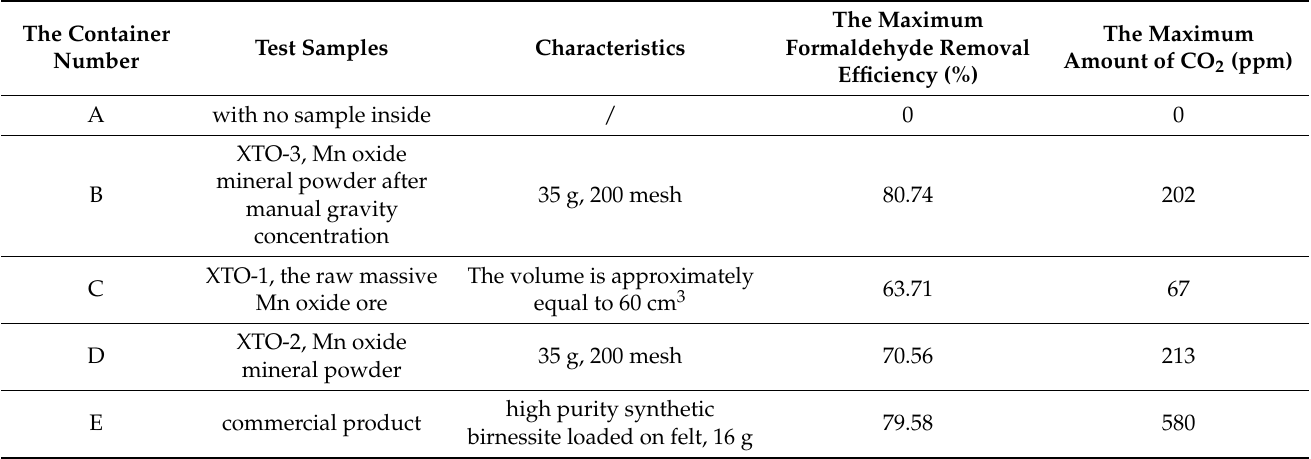
Figure 7. Comparison of formaldehyde catalytic activity of different samples. ( a ) Comparison of formaldehyde removal efficiency of different samples; ( b ) comparison of CO 2 concentration of different samples. Table 3. Experimental results of formaldehyde removal test at room